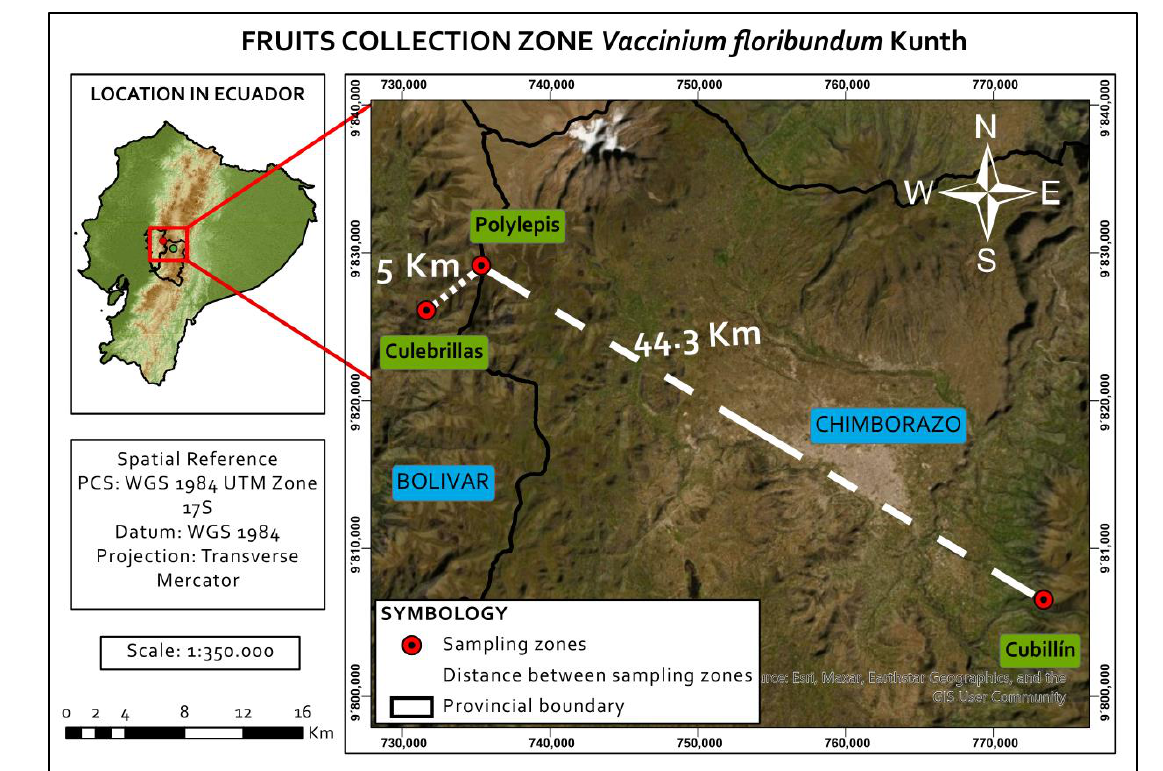
Figure 1. The three paramo zones where the mortiño berries were harvested.